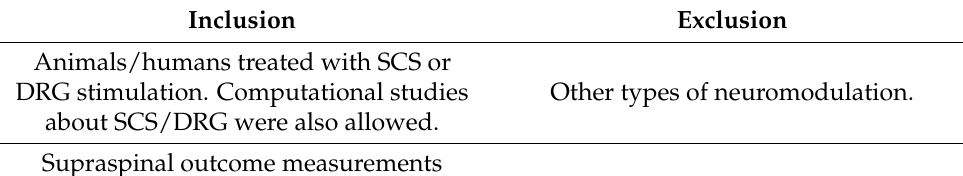
Table 1. Eligibility criteria. Abbreviations. DRG: dorsal root ganglion, SCS: spinal cord